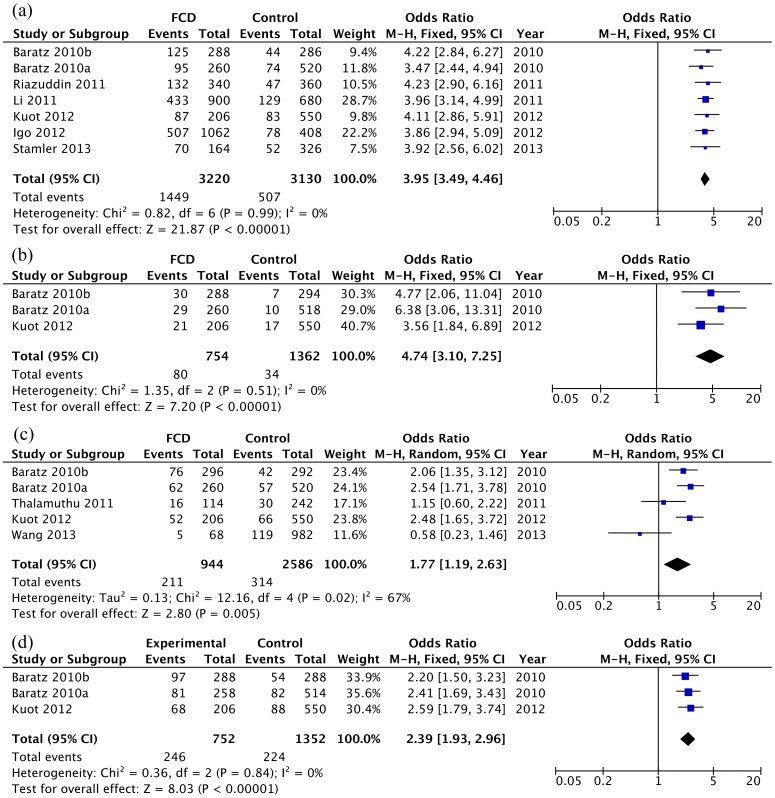
Forest plot of TCF4 allelic model: (a) TCF4 rs613872 (b) TCF4 rs17595731 (c) TCF4 rs2286812 (d) TCF4 rs9954153.Squares indicate the study-specific odds ratio (OR). The size of the box is proportional to the weight of the study. Horizontal lines indicate 95% confidence interval (CI). A diamond indicates the summary OR with its corresponding 95% CI.